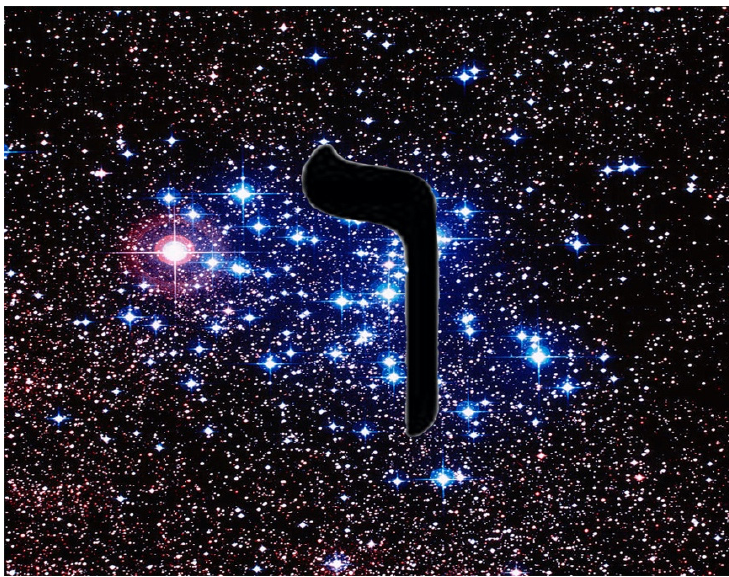
Figure 2. The Vov and Moral Space-Time.